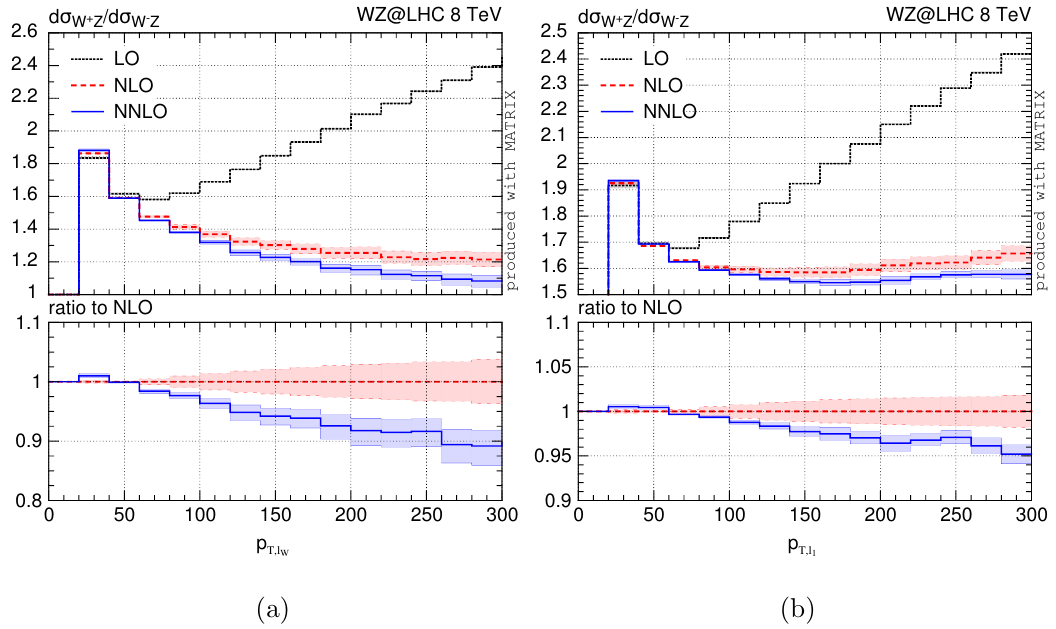
Figure 11 . Ratio of W + Z and W (cid:0) Z distributions in (a) the transverse momentum of the lepton associated with the W decay and (b) the transverse momentum of the hardest